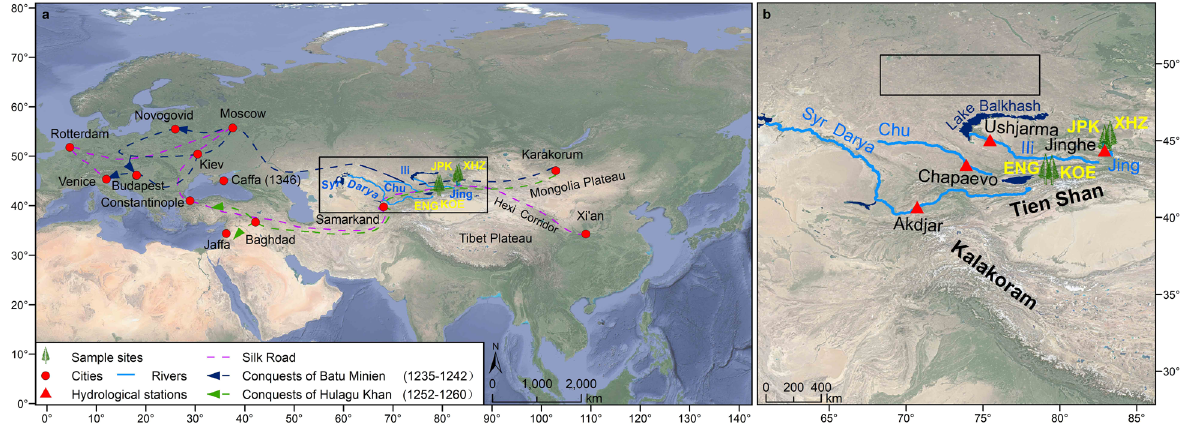
Fig. 1 Map of the study area. a Route of Mongol conquests (arrows), capital cities of the Mongolian Empire (Karakorum) and Timurid Empire (Samarkand), and silk road. The river basins are also shown (Rectangle). b Map showing the locations of the four sampling sites and hydrological stations with main rivers in Central Asia. The Pre-Balkhash plague focus area of southern Kazakhstan is also shown (Rectangle).